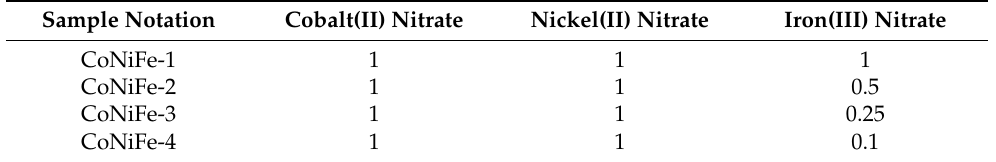
Table 4. Molar ratios of metal nitrates for the synthesis of cobalt-nickel-iron